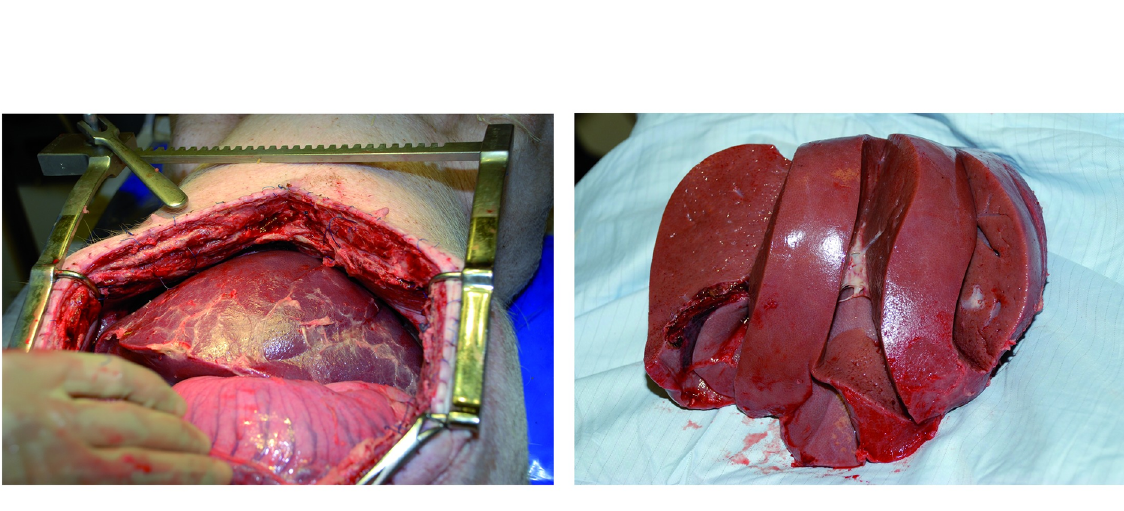
Fig 9. Liver at the end of perfusion and follow-up. (A) Post-transplant appearanceof a liver after normothermic machine preservation for 48 hours; (B) porcine liver at autopsy following48 hour normothermic preservation and five days of recipientfollow- up.